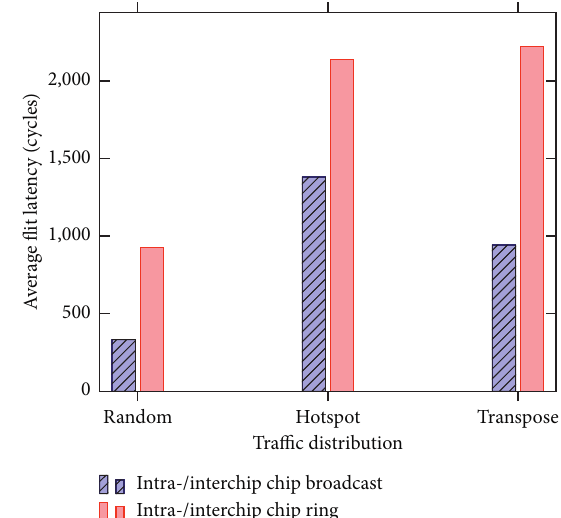
Figure 18: The average latency of the proposed THz multichip system in comparison with token-based mm-wave one with nonuniform traffic (PIR � 0.01).